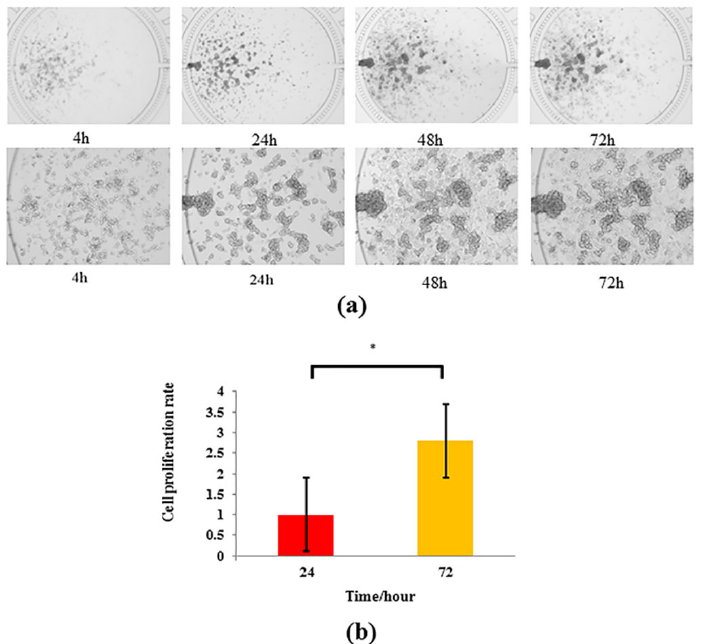
Figure 3. Growth status of HepG2 cells cultured on microfluidic chip. ( a ) Growth of HepG2 cells under (×4) and (×10) lenses for 4 h, 24 h, 48 h and 72 h. ( b ) Proliferation rate of HepG2 cells at 24 h and 72 h ( n = 3). * p < 0.05 is compared with 24 h group.